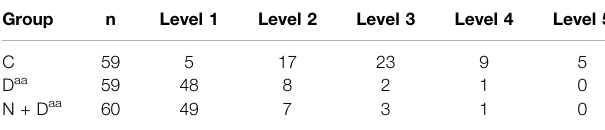
TABLE 5 | Comparison of cough grading at tube removal among